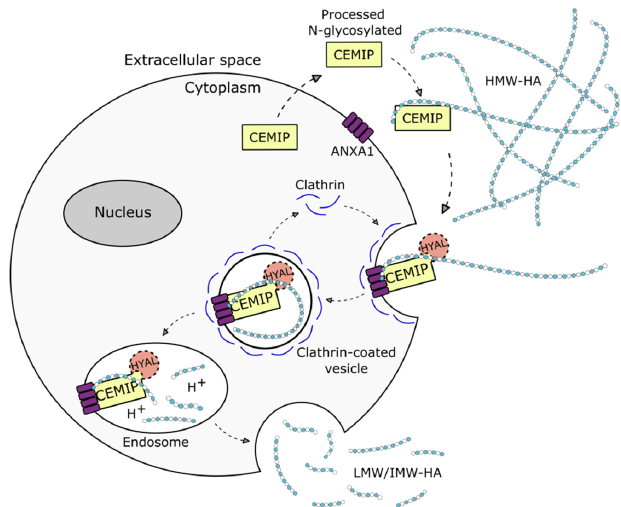
Figure 2. Schematic representation of the proposed mechanism of action for CEMIP-mediated degradation of hyaluronan (HA). Extracellular CEMIP binds to high molecular weight (HMW) HA and internalizes it via clathrin-coated endocytosis after binding to annexin A1 (ANXA1). In the endosome, HMW-HA is degraded into low and intermediate (LMW/IMW) HA. The degraded HA fragments are subsequently released back into the extracellular milieu. HYAL represents a hypothetical bone fide hyaluronidase that might conceivably participate in CEMIP-mediated HA degradation. The hyaluronidase activity of CEMIP may account for its tumor- and metastasis- promoting role in a number of ways. CEMIP has been reported to be localized at the invasive front of colon cancer tissue [17], and the hyaluronidase activity may conceivably contribute to tissue invasion through the degradation of HA-dependent migratory